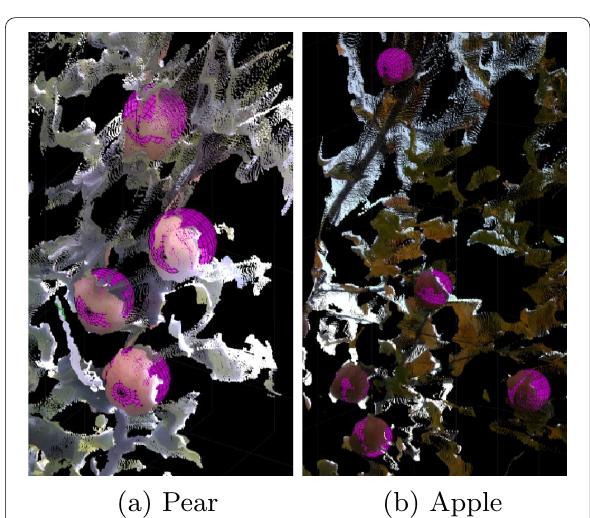
Fig. 12 Results of sphere shape estimation